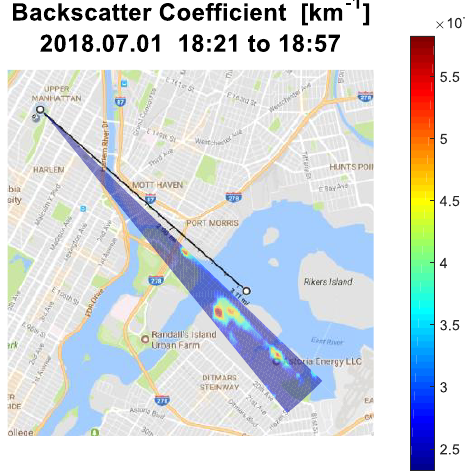
Figure 1. Backscatter coefficient map for July 1st, 2018 between 18:21 and 18:57 EDT.